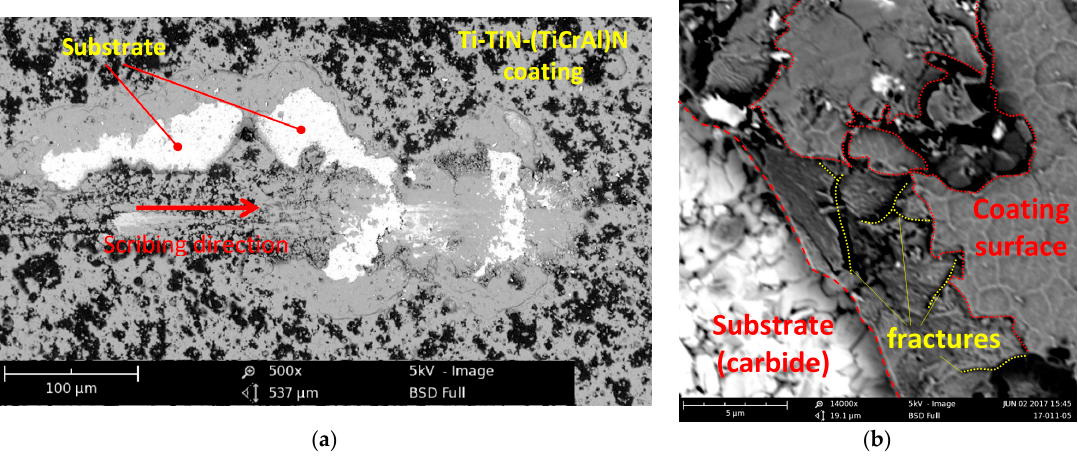
Figure 3. Fracture pattern for multilayered nano-structured coating Ti-TiN-(TiCrAl)N (thickness of about 5 µm) in scratch testing: ( a ) General view of scribing groove in area of L c1 –L c2 ; ( b ) Area of coating fracture.